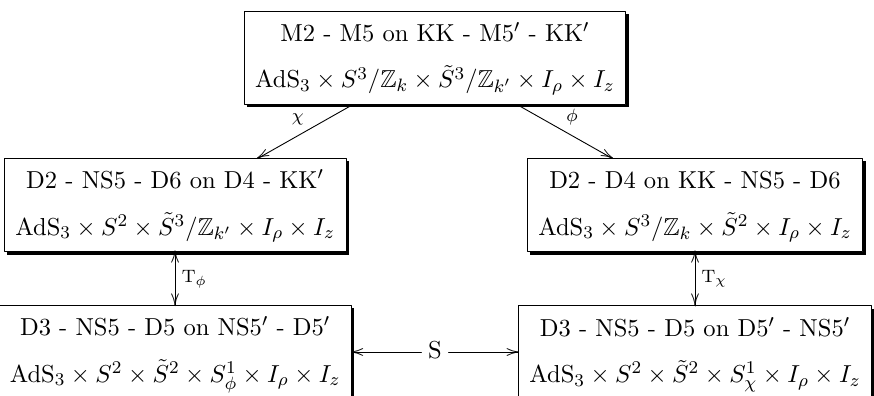
Figure 1 . Relations among the N = (0 , 4) AdS 3 backgrounds in Type II and M-theory discussed in this section. In the most general case the M-theory brane set-up can be reduced over the T 2 parametrised by the ( χ, φ ) coordinates to describe an intersection of D3 branes with orthogonal ( p, q )